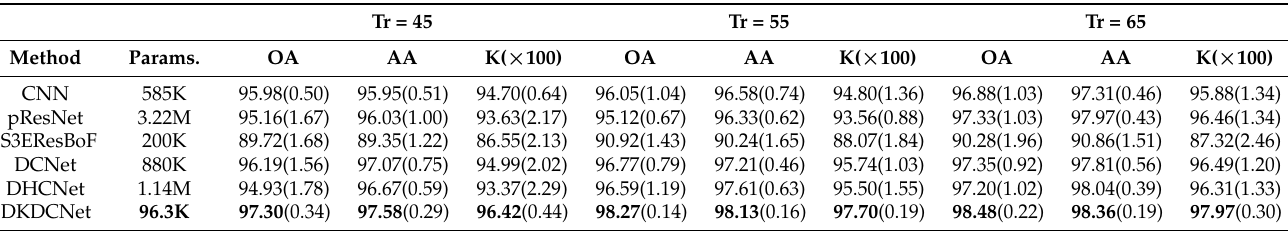
Table 2. Classification results and number of parameters obtained for UP scene. Tr = 45 Tr =